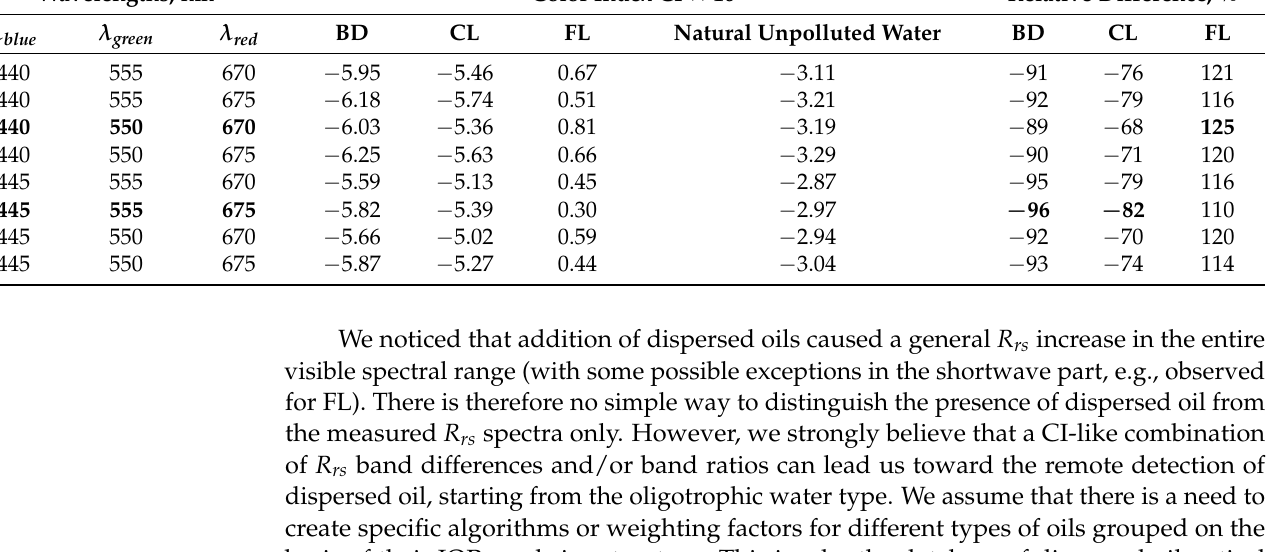
Table 3. Color index (CI) values (multiplied by 10 3 ) for oligotrophic ocean waters calculated for different combinations of λ blue , λ green and λ red and compared for natural unpolluted water and polluted by three kinds of dispersed oils: biodiesel BD, lubricant oil CL and crude oil FL. Wavelengths, nm Color Index CI × 10